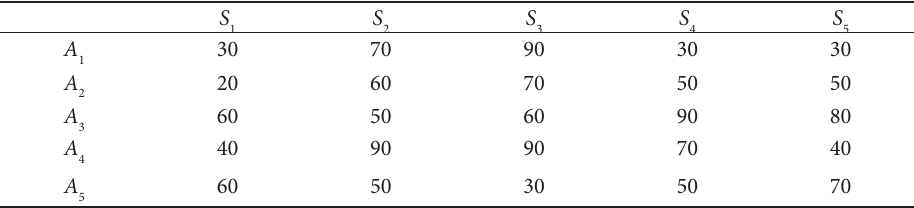
Table 1. Payoff matrix – Expert 1